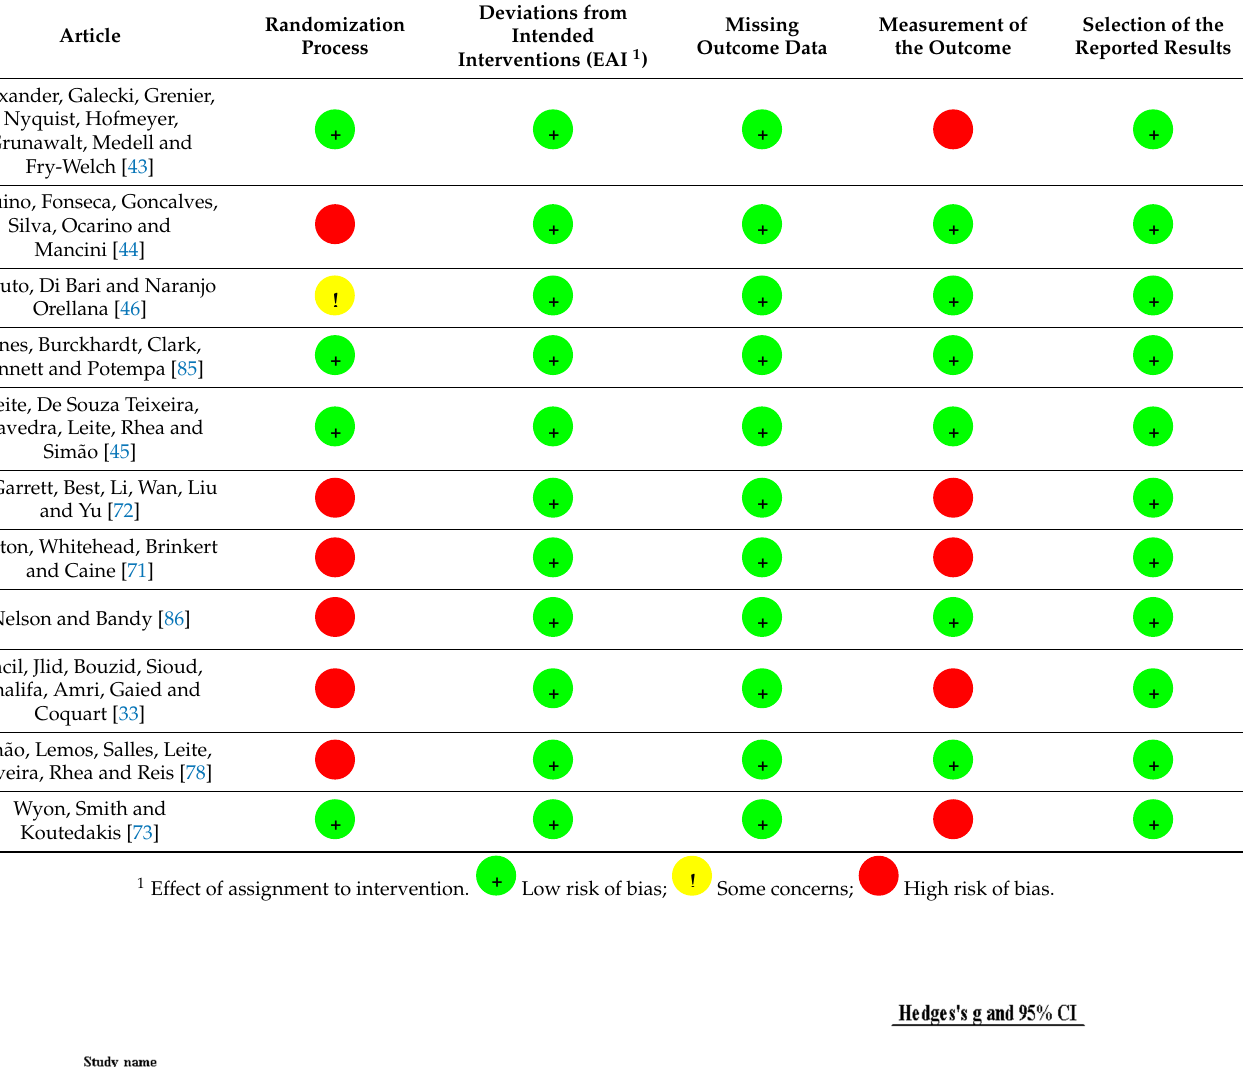
Table 2. Assessments of risk of bias (Cochrane’s RoB 2).